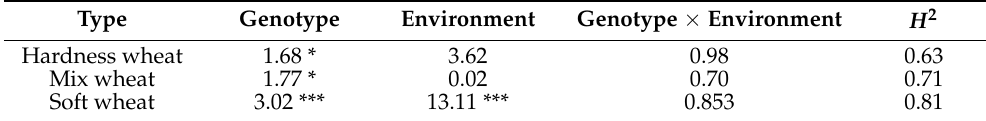
Table 2. Analysis of variance of HI trait in 150 wheat accessions.